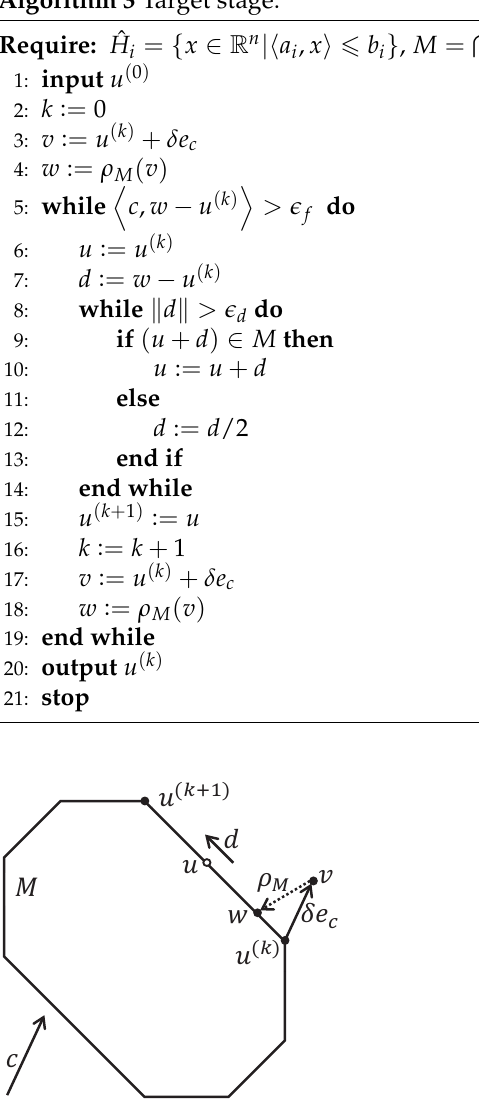
Figure 1. Iteration execution scheme of the target